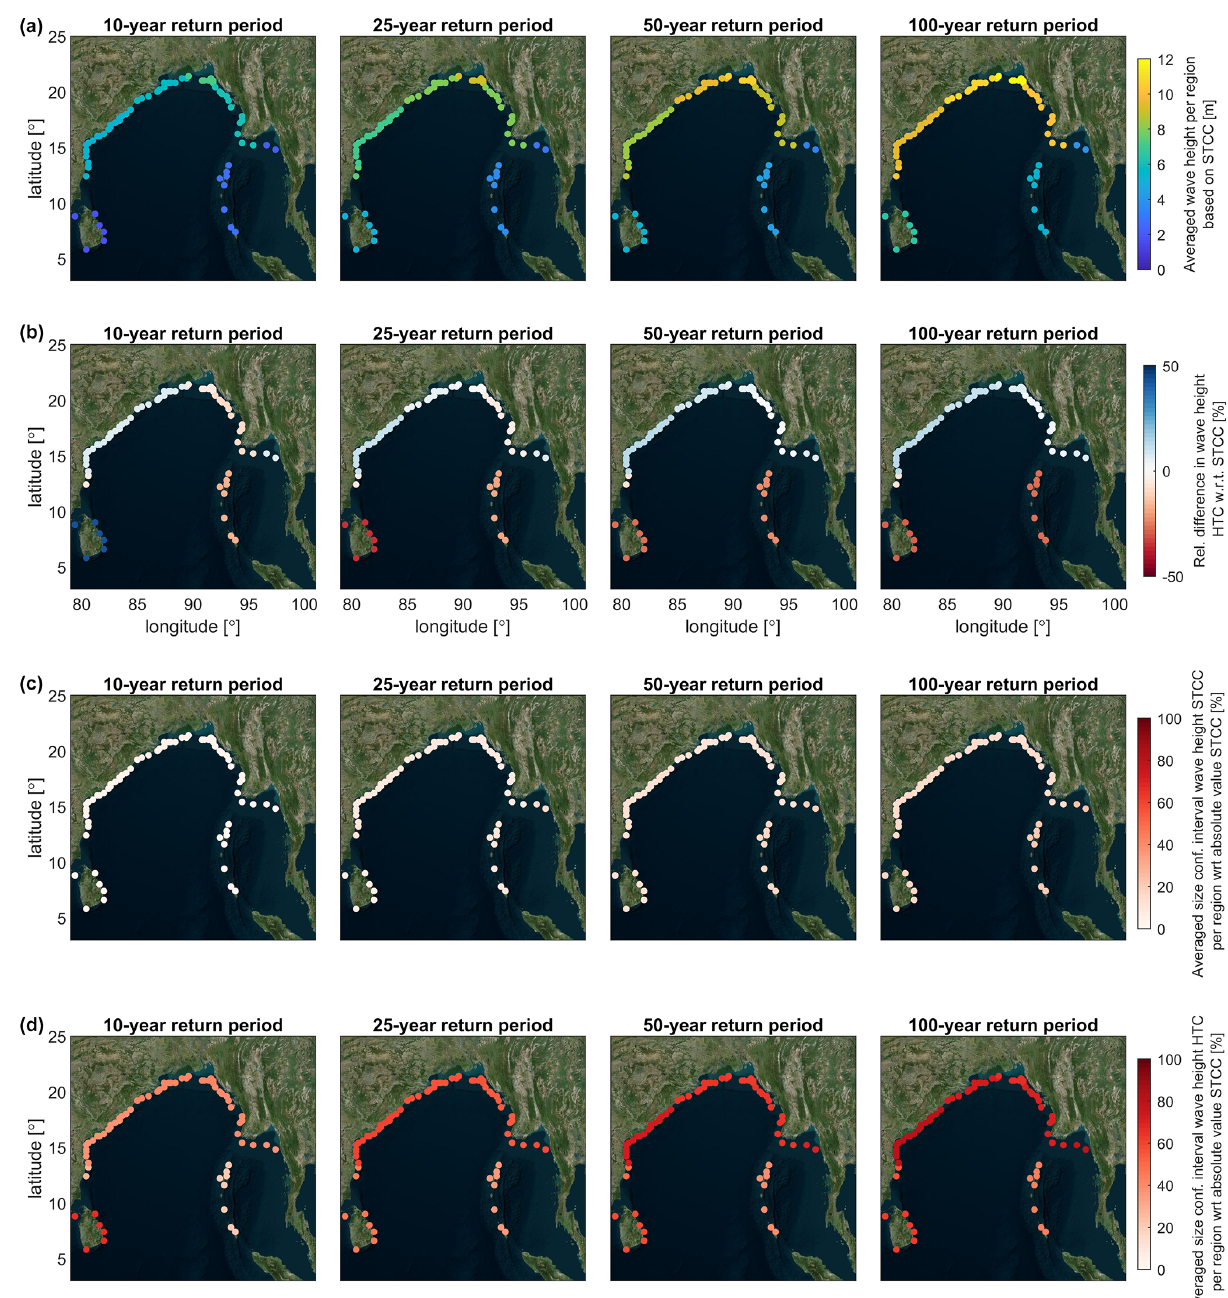
Figure 13. (a) Regionally averaged wave heights along the Bay of Bengal estimated based on STCC for return periods of 10, 25, 50 and 100 years. (b) Regionally averaged relative difference (in %) of wave heights estimated based on HTCs compared to STCC of panel (a) . (c) Regionally averaged size of confidence interval of wave heights based on STCC as a percentage (%) of the absolute value of STCC of panel (a) . (d) Regionally averaged size of confidence interval of wave heights based on HTCs as a percentage (%) of the absolute value of STCC of panel (a)